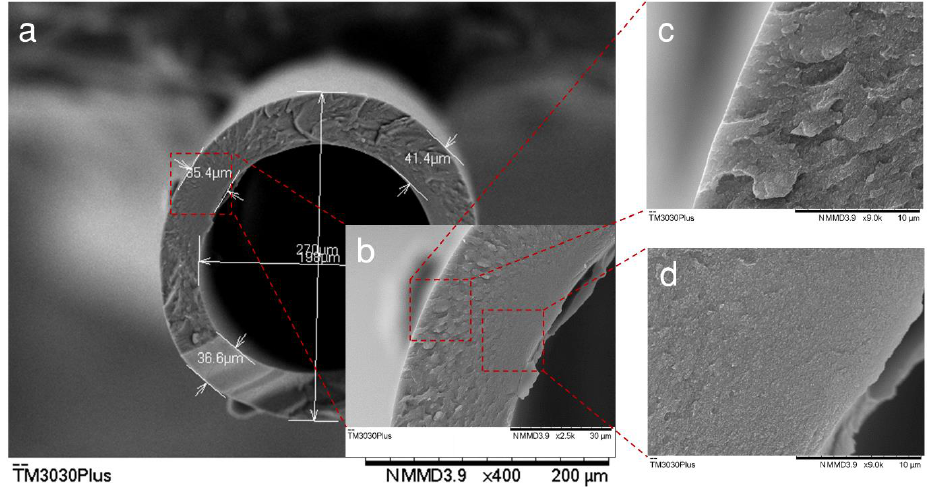
Figure 5. SEM images of ( a,b ) cross section of CHF; ( c ) outside layer of CHF; ( d ) inside layer of CHF.